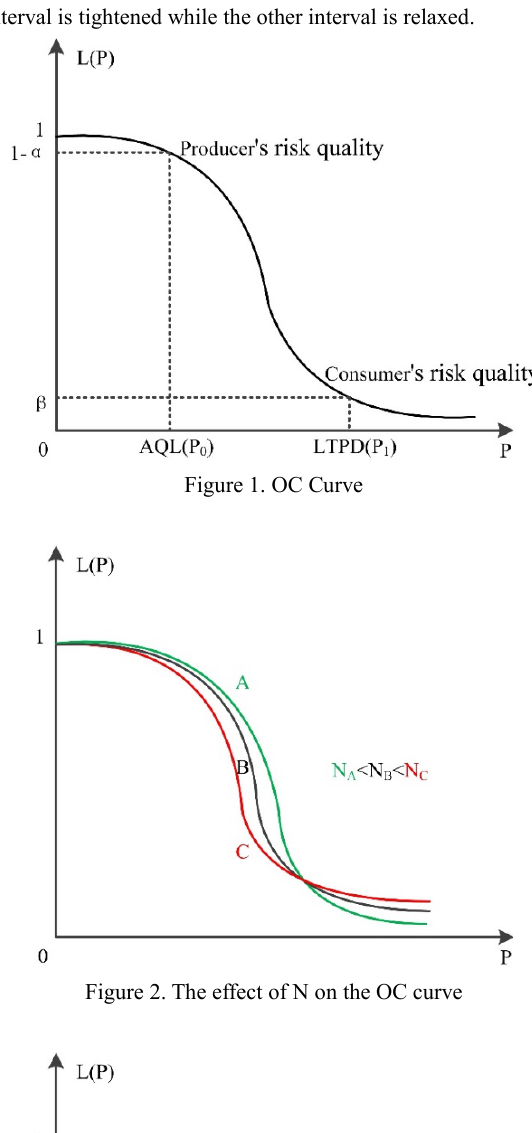
Figure 2. The effect of N on the OC curve